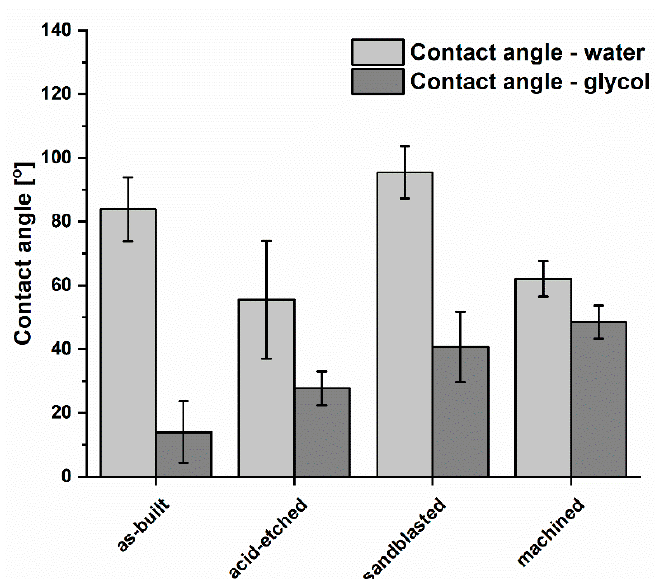
Figure 7. Comparison of wettability of titanium alloy surface after various types of treatment (average values and standard deviation).